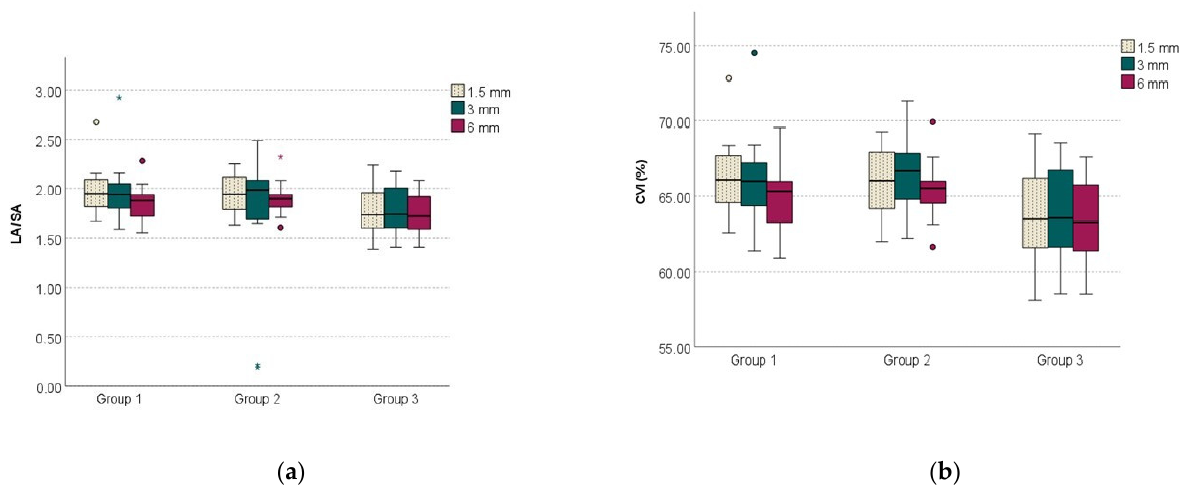
Figure 3. Choroidal parameters calculated as ratios for the three studied areas: ( a ) LA/SA ratio; ( b ) CVI.